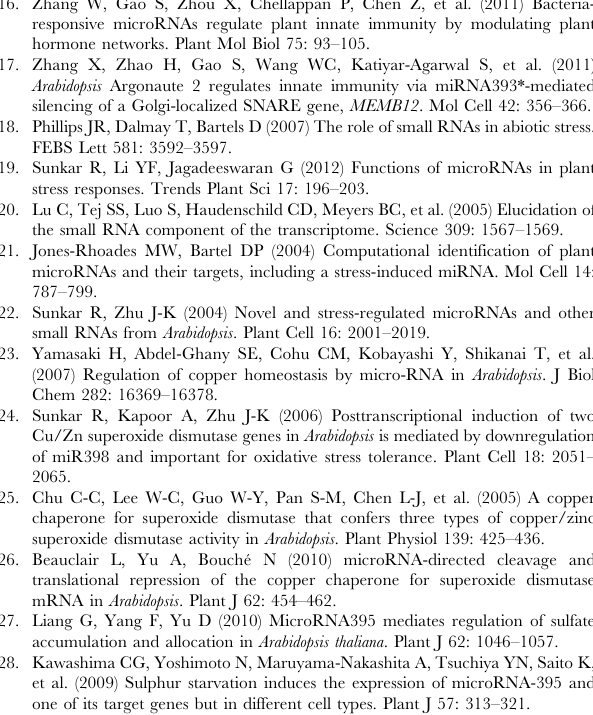
Figure S4 Overlap of conserved miRNAs identified in B. juncea with previously reported miRNAs in A. thaliana and A. lyrata . Table S1 Details of primers used in this study. (XLSX) Table S2 The total number of purity filtered sRNA reads obtained through high-throughput sequencing and the number of sRNA reads having adapter sequence both in redundant and unique datasets. Table S3 Conserved miRNA sequences identified in B. juncea with their absolute counts, normalized counts and fold change values in control and different abiotic stress conditions. Table S4 Precursor sequences of conserved miRNAs. (XLSX) Table S5 Variants of conserved miRNA sequences identified in B. juncea. Table S6 True novel miRNA sequences identified in B. juncea with their absolute counts, normalized counts and fold change values in control and different abiotic stress conditions. Table S7 Precursor sequences of true novel miRNAs. (XLSX) Table S8 Candidate novel miRNA sequences identified in B. juncea with their absolute counts, normalized